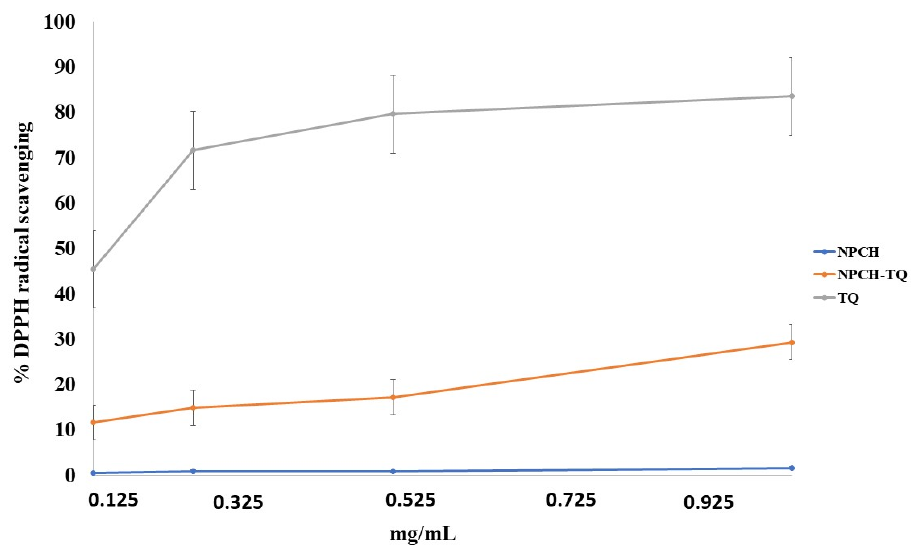
Figure 3. DPPH scavenging of free TQ, NPCH, and NPCH-TQ.